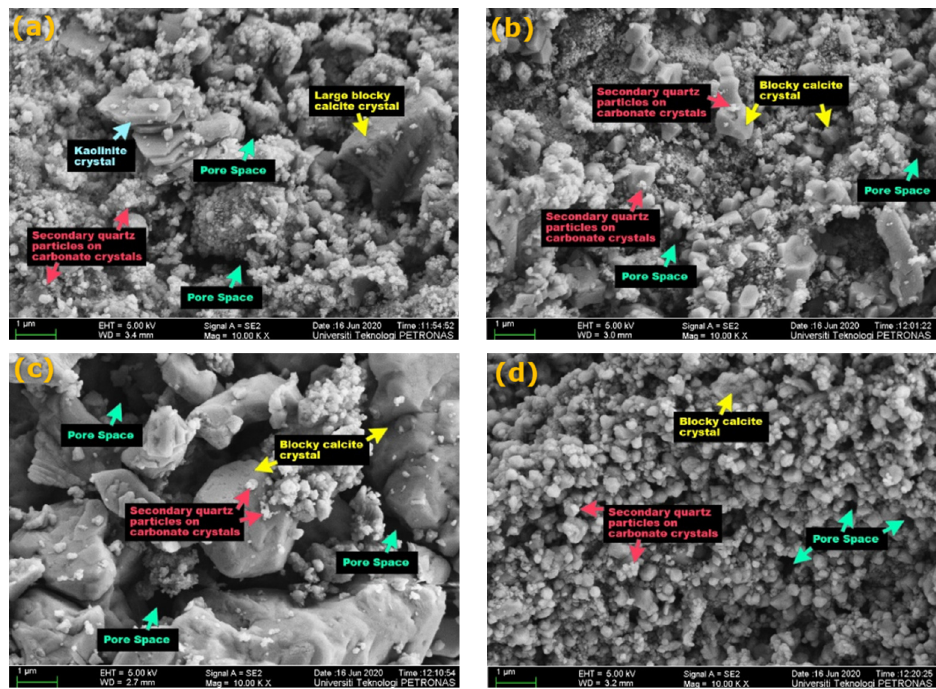
Figure 17. FESEM image showing the presence of micro-pores of sample ( a ) A-2.1, ( b ) A-2.2, ( c ) A- 2.3 and ( d ) A-2.4.